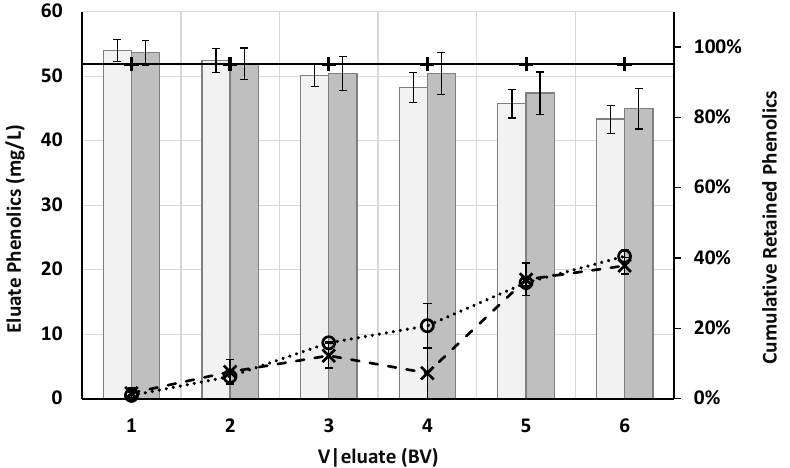
Figure 1. Phenolic compound concentrations (mg/L) in the eluates ( lines ) and corresponding percentages of phenolics cumulative retention ( columns ) in resin XAD ‐ 2 ( ○ , lighter grey ) and HP ‐ 20 darker grey ) for the different eluted volumes ( V|eluate ). Solid line marks the phenolic compounds concentration in the spent